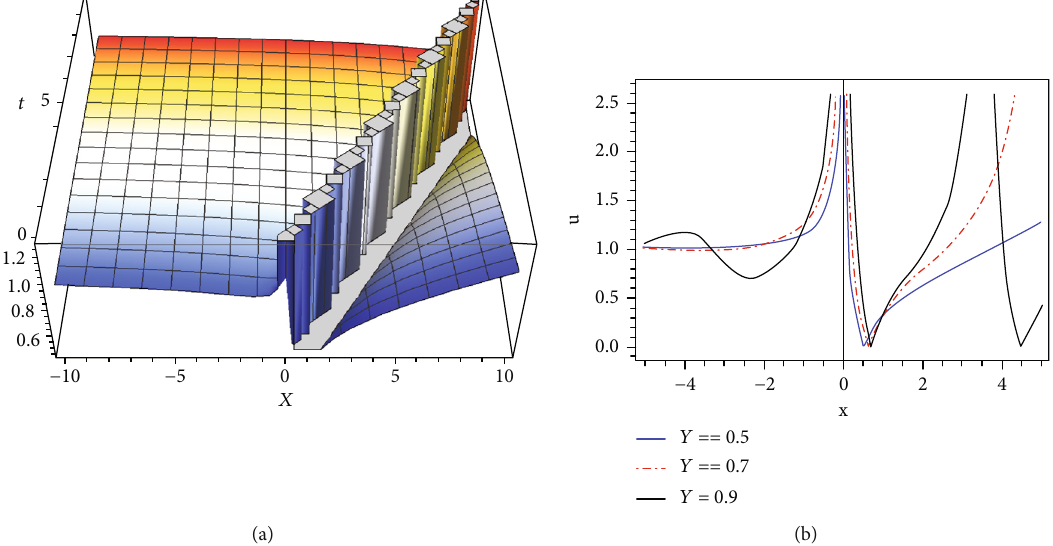
= 1 , T = 2 , V = 1 , c = 3 , a = 1 , b = 1 , and γ = 0 : 5,0 : 7,0 : 9 for the solution j u 1